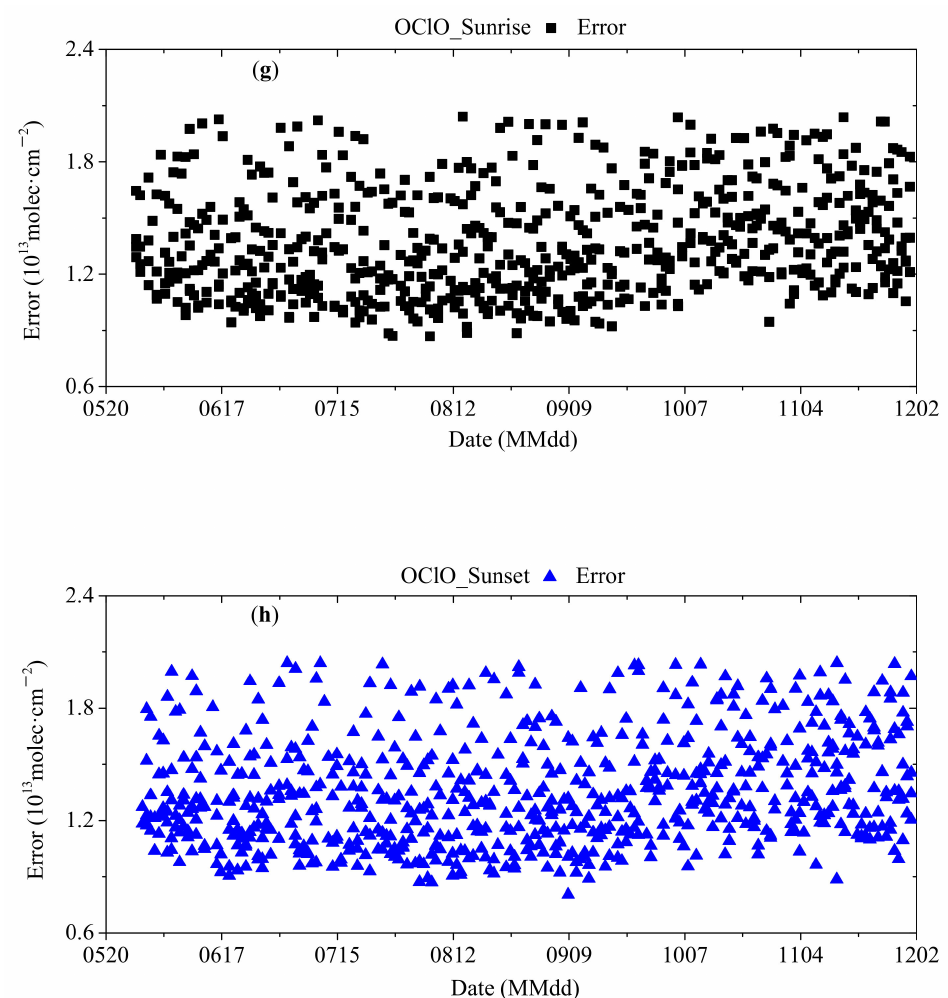
Figure A1. Time series of the fit absolute errors and relative errors of ( a ) O 3 , ( c ) NO 2 , ( e ) BrO, and ( g ) OClO dSCDs at sunrise. ( b , d , f , h ) are the same as ( a , c , e , g ) respectively, but for sunset. The black squares and the blue triangles denote the fit absolute error, while the blue circles and the green stars denote the relative error.